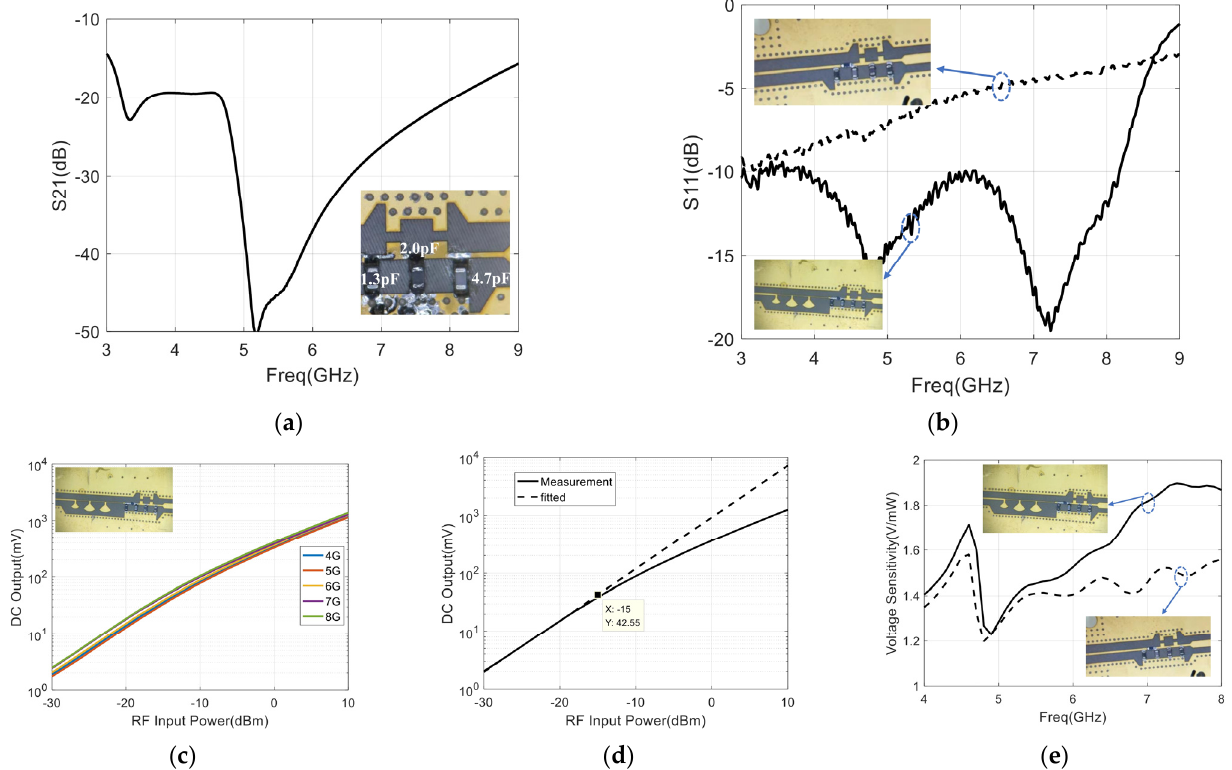
Figure 8. The measurement result of the detection circuit: ( a ) The measurement result of LPF; ( b ) The return loss of both types of detectors; ( c ) Measured DC output versus input power at different frequencies; ( d ) The square-law detection region of the detector; ( e ) The voltage sensitivity of the detector when the input power is − 20 dBm.